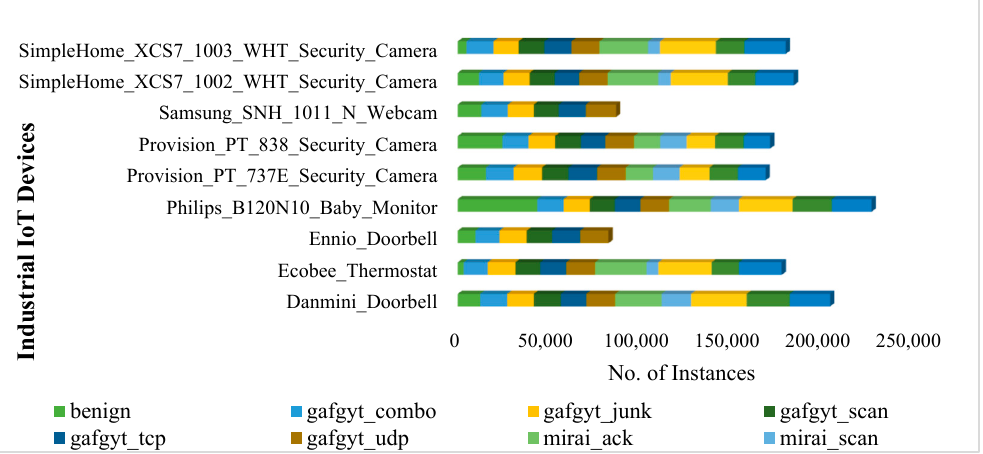
Figure 1. Number of instances in each IoT device.